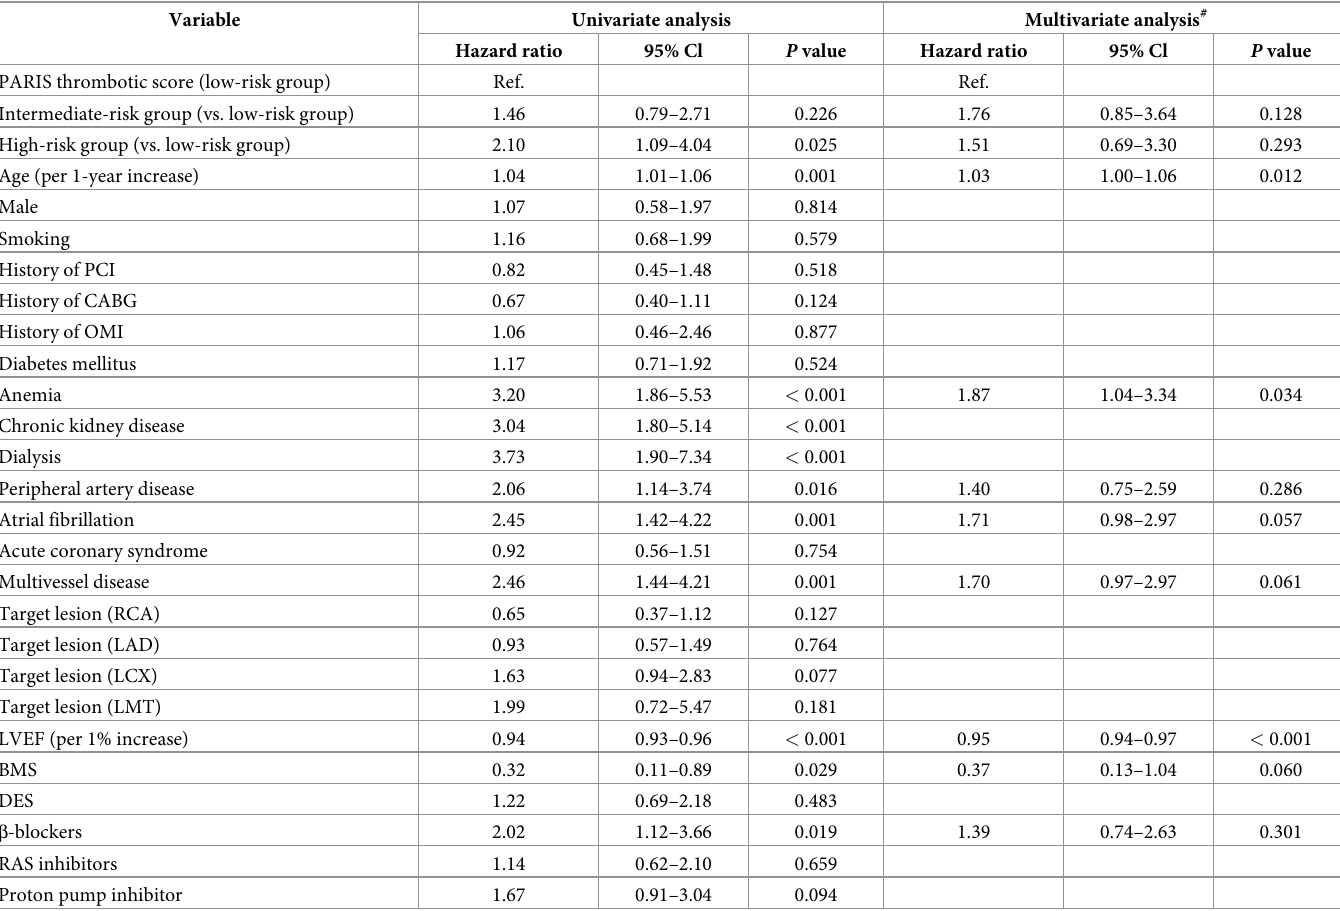
Table 3. Cox proportional hazard model of PARIS thrombotic score for cardiac